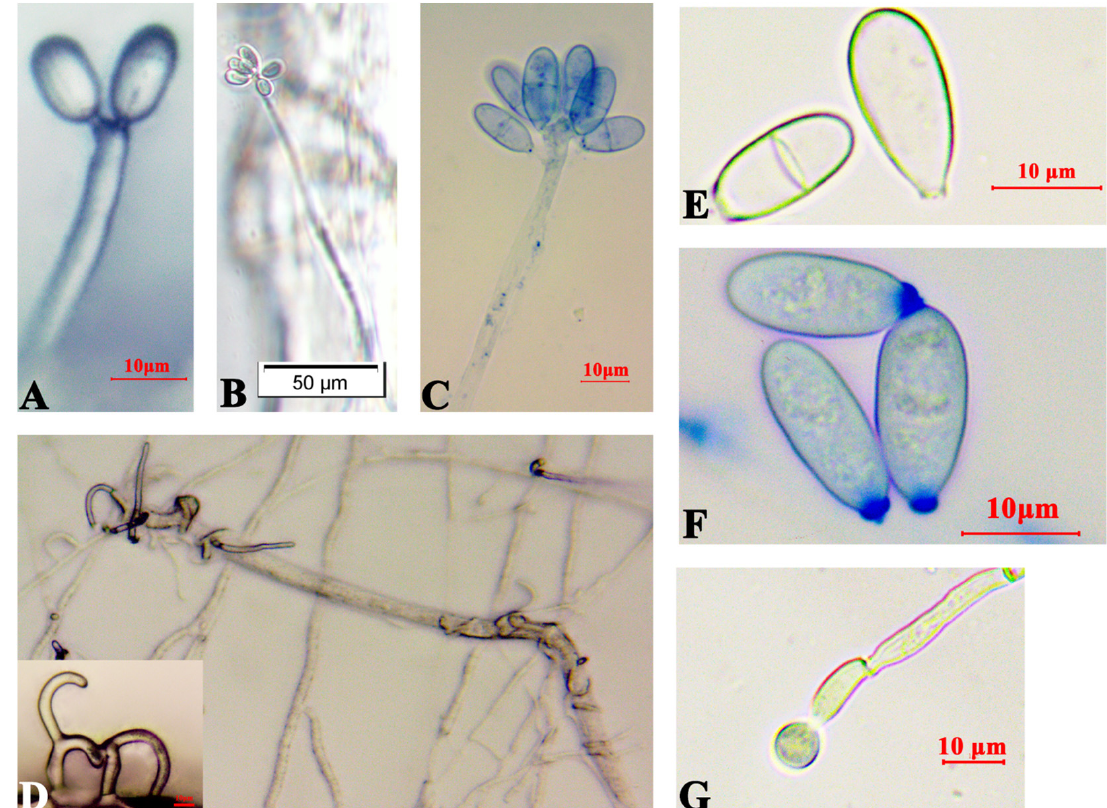
Figure 1. Morphology of Arthrobotrys robusta on LCMA. ( A – C ) Mycelium and conidiophores; ( D ) Bundled PWNs and three-dimensional fungal cords; ( E , F ) Conidia; and ( G ) Chlamydospores.